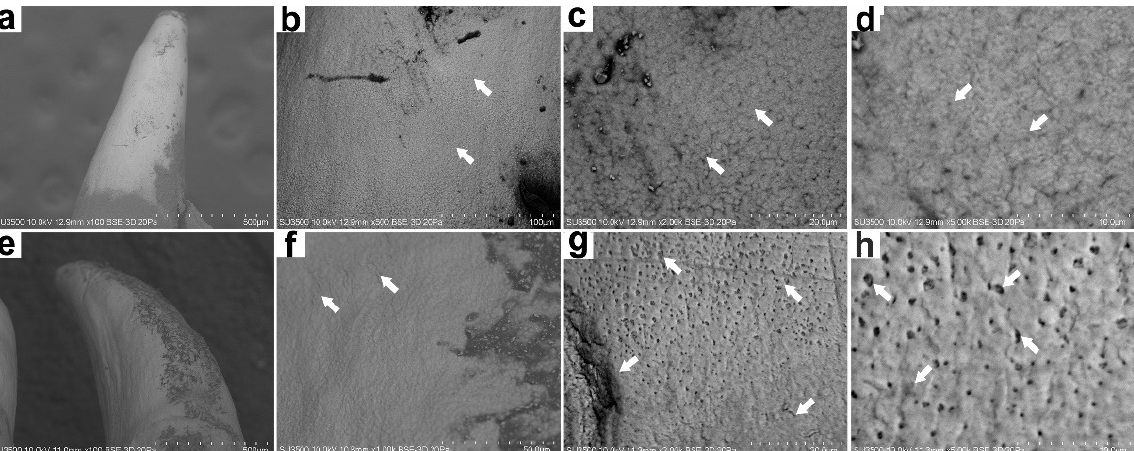
Figure 2. Microstructure of rainbow trout ( Oncorhynchus mykiss ) teeth. Farm fish at 500×, 1000×, 2000× and 5000× magnification ( a – d ). Wild fish at 500×, 1000×, 2000×, and 5000× magnification ( e – h ). Backscatter detector (BSD) image. Scanning Electron Microscope SU3500, Hitachi,Tokyo, Japan.